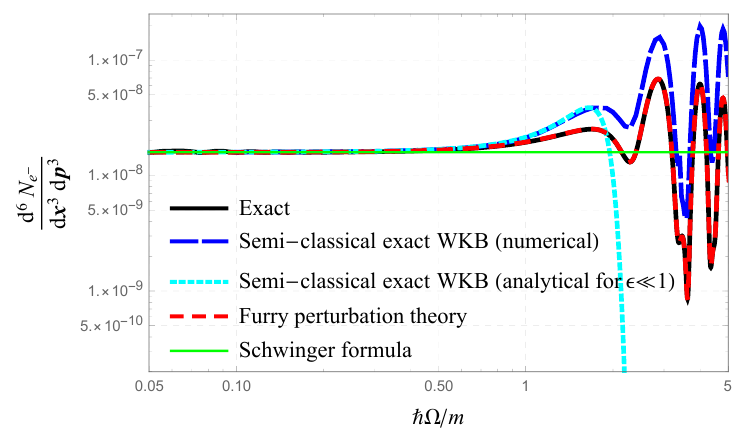
Figure 4 . (color online) The production number for a constant strong electric field superimposed by a weak monochromatic perturbation (3.56). The parameters are fixed as ~ eE s /m 2 = 0 . 25 , E w /E s = 0 . 01 , | p ⊥ | /m = 0 , and p /m = 0 . 20 . The black line is an exact result, obtained by numerically k solving the mode equation (3.1). The long dashed blue line is obtained by the semi-classical exact WKB formula (3.33), in which we have numerically determined turning points (see appendix E for the resulting Stokes graphs) and computed the corresponding actions S z ’s. The dotted cyan line t represents the analytical formula (3.53), which is obtained by expanding the exact WKB formula in terms of | E w /E s | (cid:28) 1 . For comparison, results of the perturbation theory in the Furry picture (C.7) and the Schwinger formula for a constant electric field (3.43) are plotted by the short dashed red line and the green line,